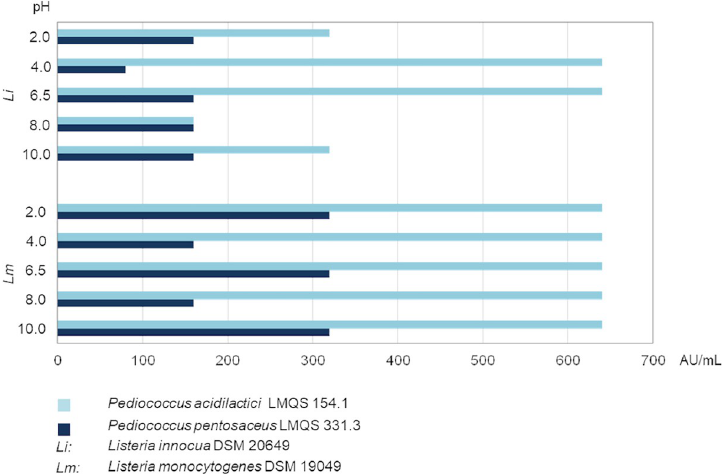
Fig 2. Antibacterial potency of CFS at pH 6.5 and after incubation at different pH values of Pediococcus pentosaceus 331.3 (traditional product) and Pediococcus acidilactici 154.1 (industrial product) at pH 6.5 and after incubation at different pH values in arbitrary units per mL (AU/mL). DSM: Leibniz Institute DSMZ-German Collection of Microorganisms and Cell Cultures, Brunswick, Germany.